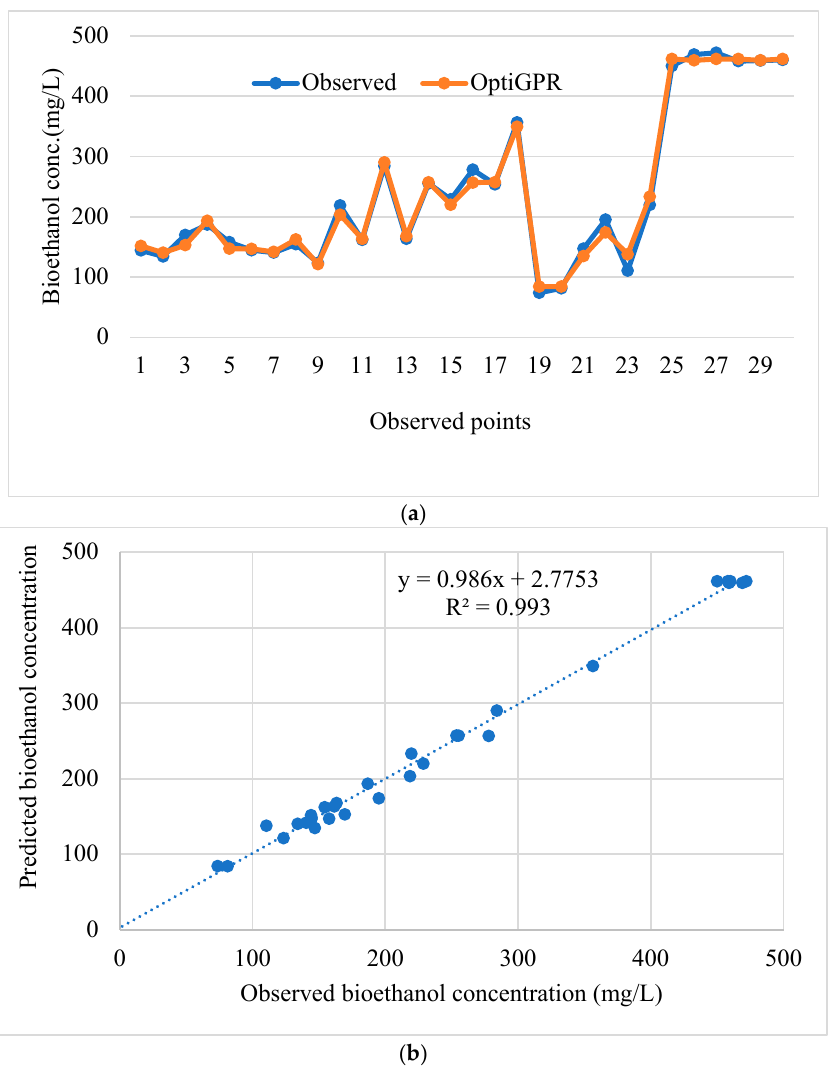
Figure 6. ( a ) Dispersion plots showing the comparison between the actual and the OptiGPR predicted bioethanol. ( b ) Regression plots showing the observed and OptiGPR predicted bioethanol.